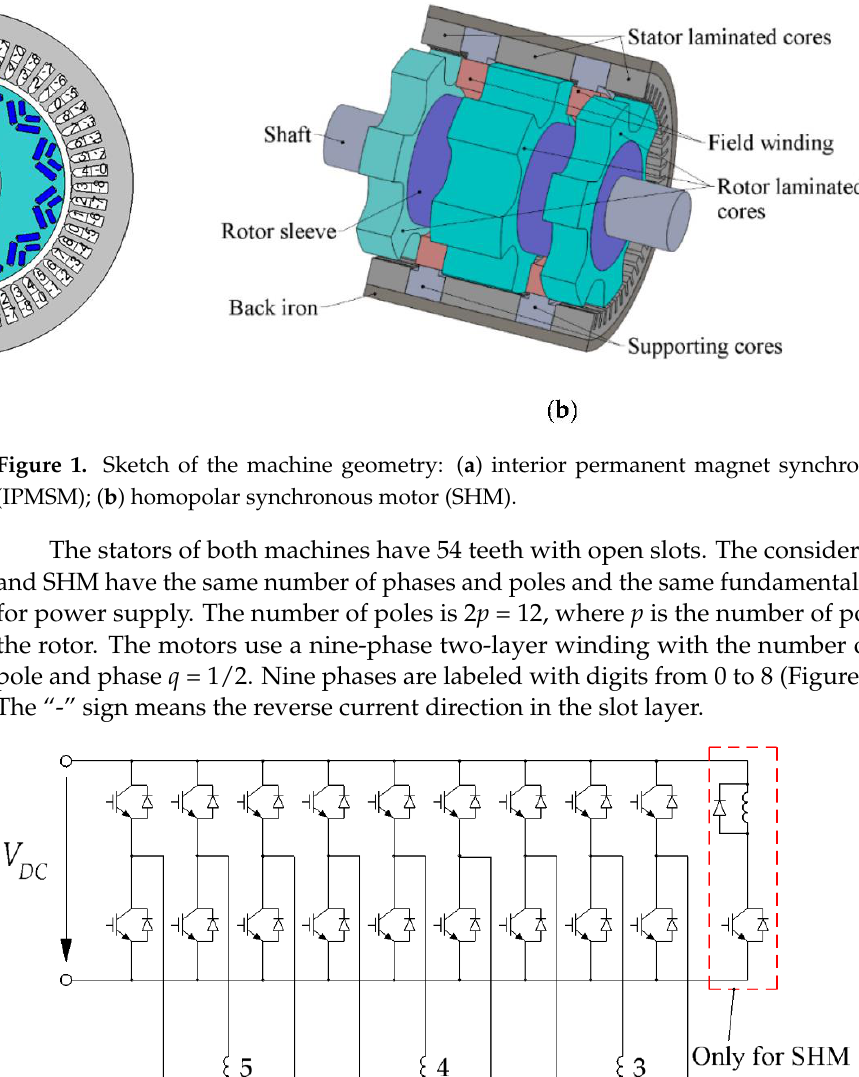
Figure 2. Nine-phase inverter schematics. The numbers indicate the phases of the nine-phase mo-